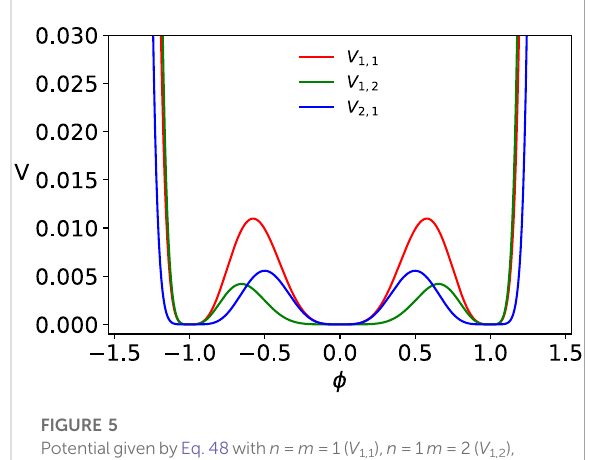
FIGURE 5 PotentialgivenbyEq.48with n = m =1( V 1,1 ), n =1 m =2( V 1,2 ), and n = 2 and m = 1 ( V 2,1 ).